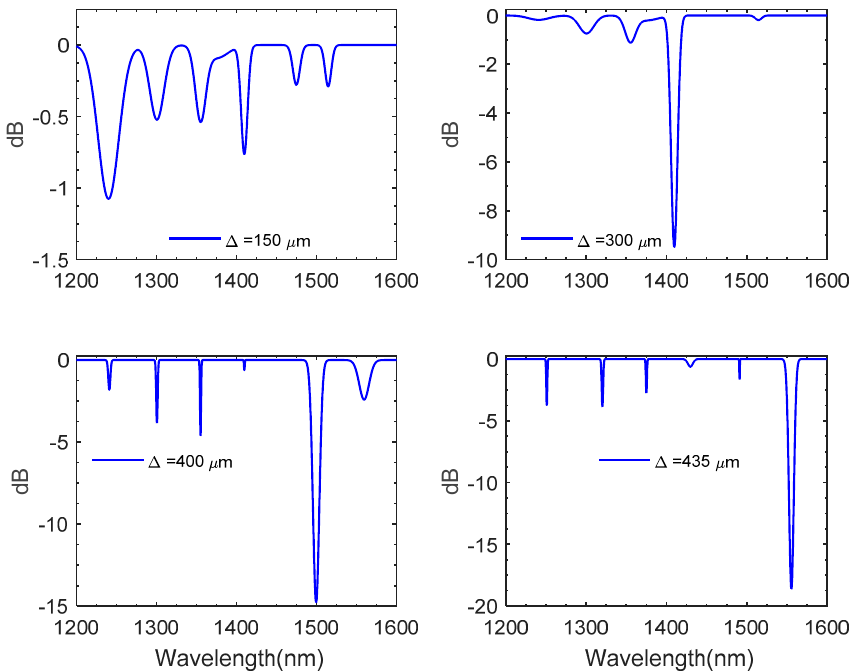
Figure 11. Transmission spectrum of an LPFG numerically modeled in SMF with various grating periods; the number of grating periods and the grating length are 42 and 100 μ m respectively.